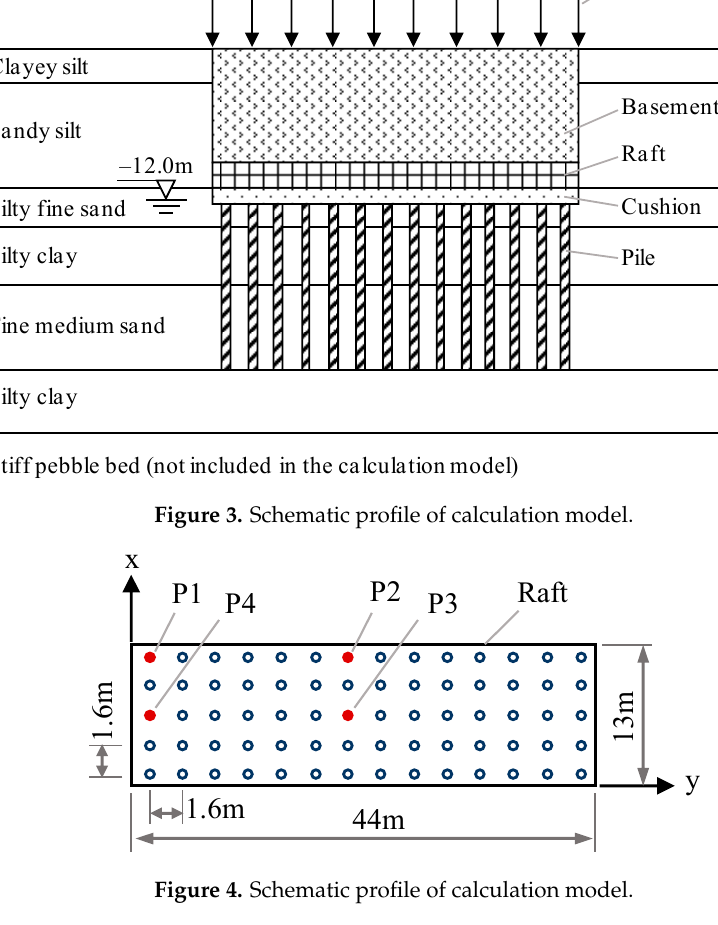
Figure 4. Schematic profile of calculation model.